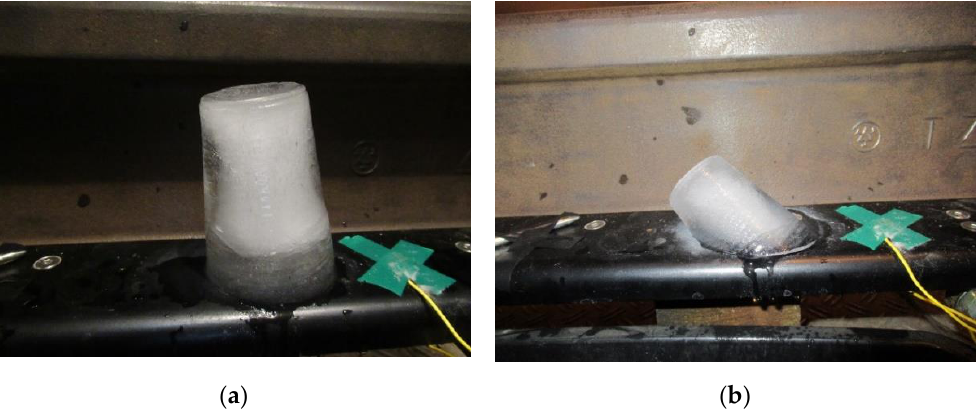
Figure 6. Ice piece melting with use of the IH device: ( a ) initial stage; ( b ) partially melted ice.